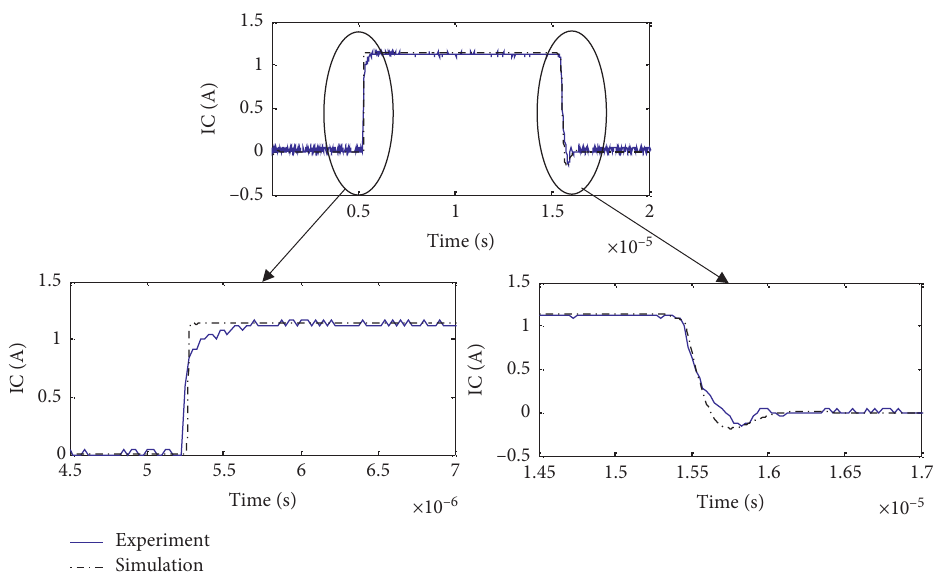
Figure 14: I C waveforms of experimental and simulated dynamic IGBT (IRGBC20U)